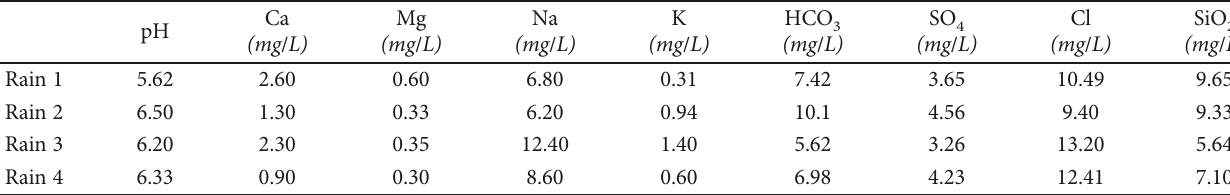
Table 2: Chemical-physical parameters of rainwater samples coming from the study